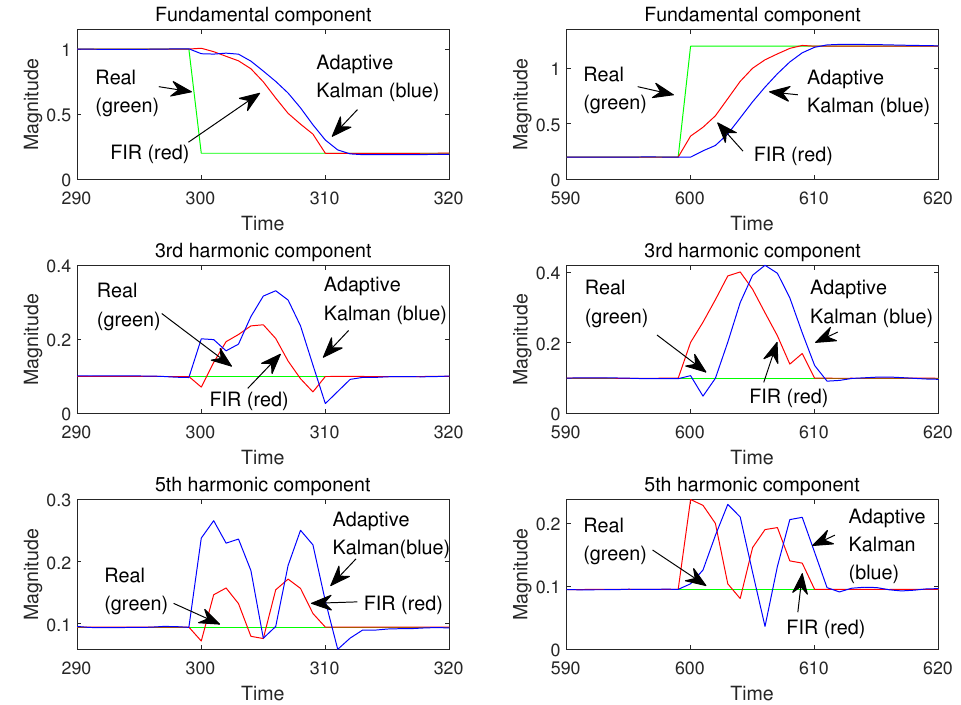
Figure 8. Real and estimated magnitude of the fundamental, third and fifth harmonic components.